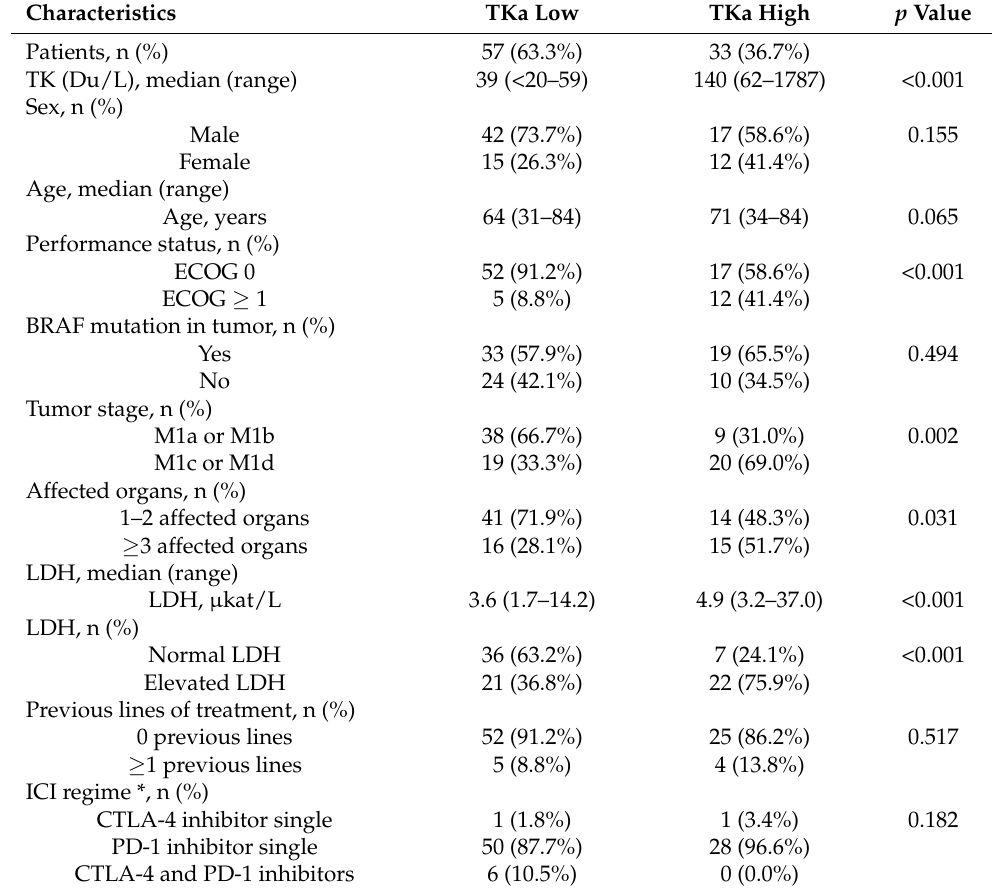
Table 2. Characteristics of melanoma patients with low (<60 Du/L) or high thymidine kinase 1 (TK) activity (Du/L) in plasma before starting immune checkpoint inhibitor treatment. Characteristics TKa